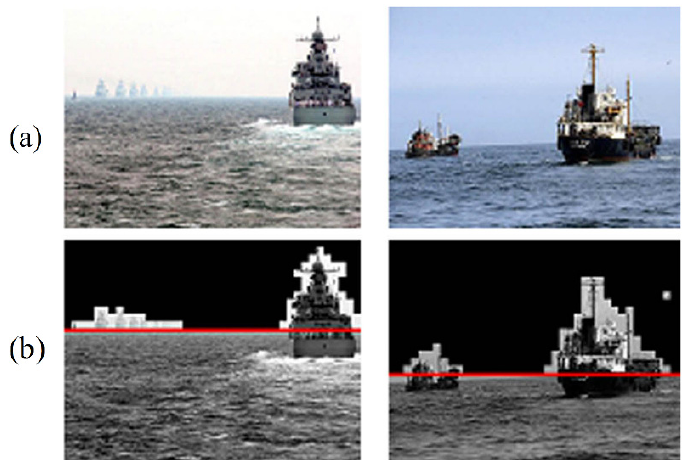
Figure 2. Typical scene depicting ship detection in a marine environment: ( a ) original images; ( b ) processed images including sea–sky line detection. Zhang et al. [55]. Copyright (2021), with permission from Elsevier.